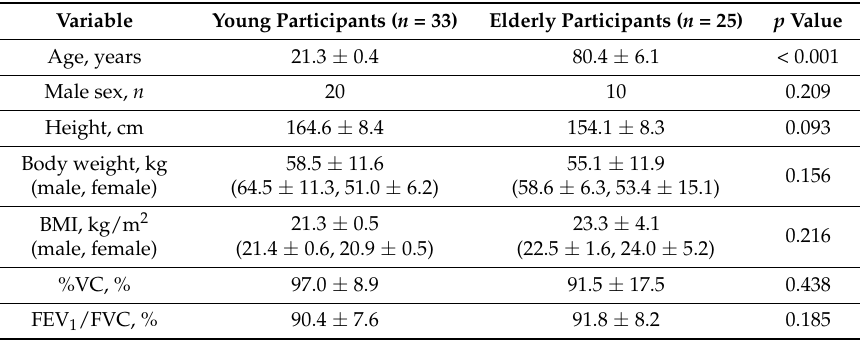
Table 1. Characteristics of the